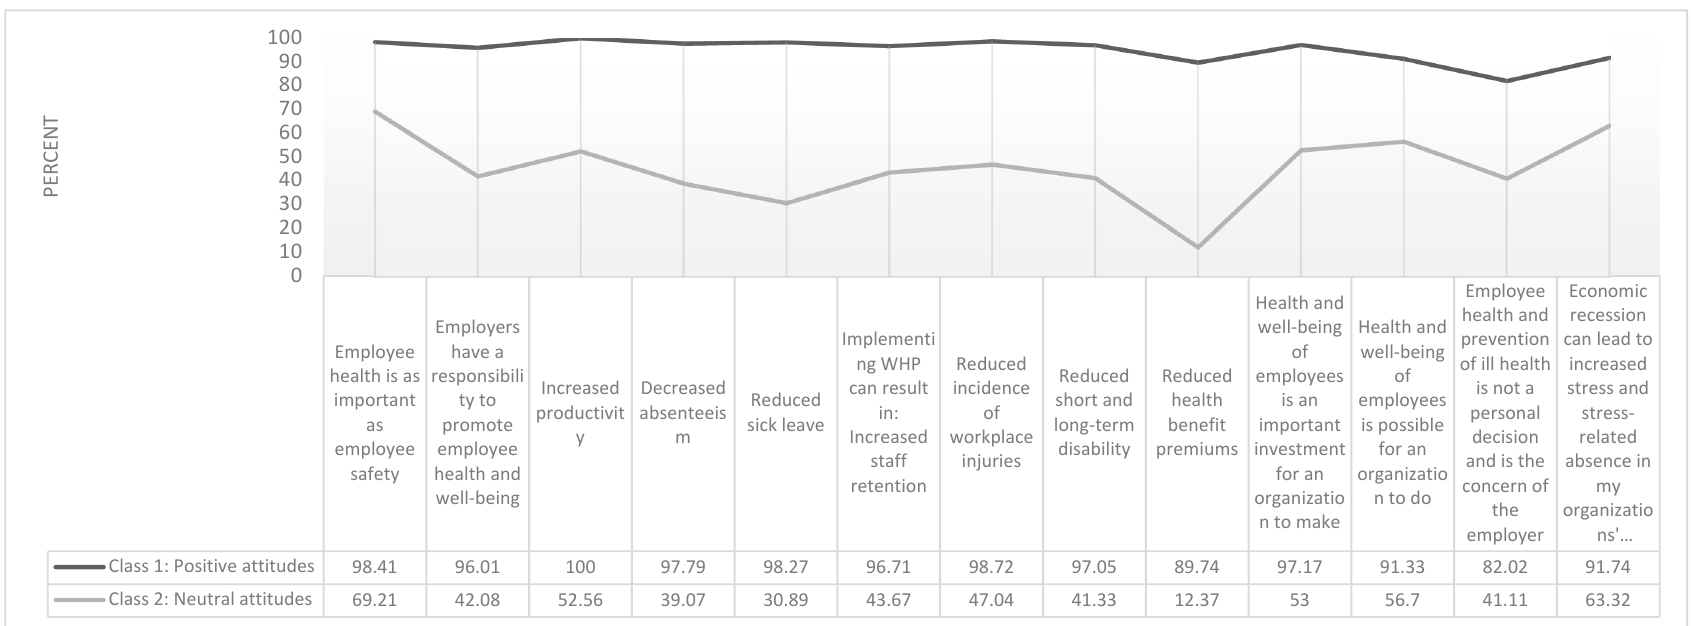
Figure 3. Percent Likelihood of Class Assignment Based on Affirmative Response to 13 WHP Attitude Items (n = 528).